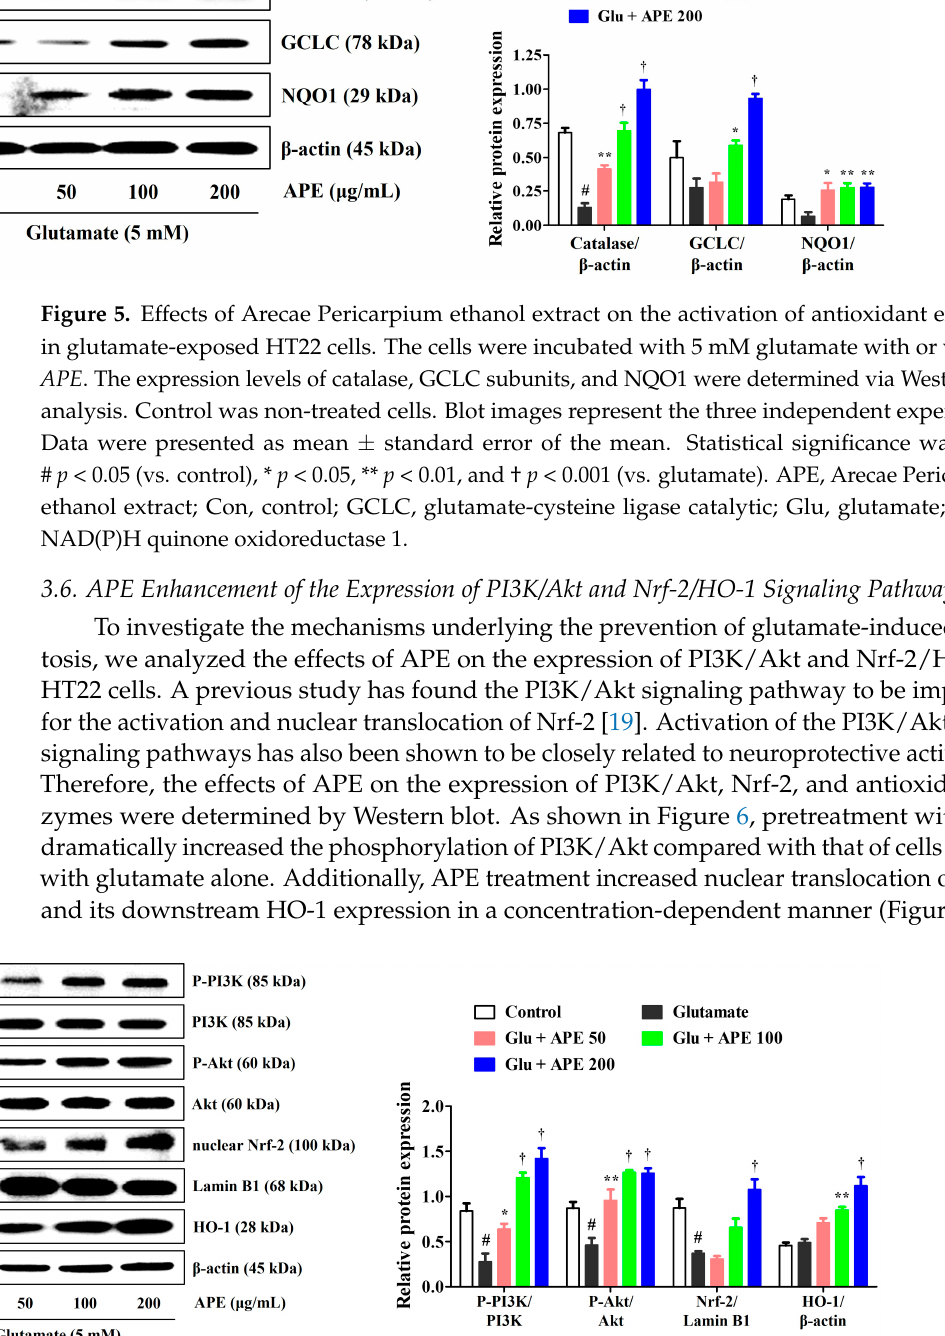
Figure 7. The suppressive effects of LY294002 on the neuroprotective action of Arecae Pericarpium ethanol extract. HT22 cells were incubated with or without APE combined with LY294002 before